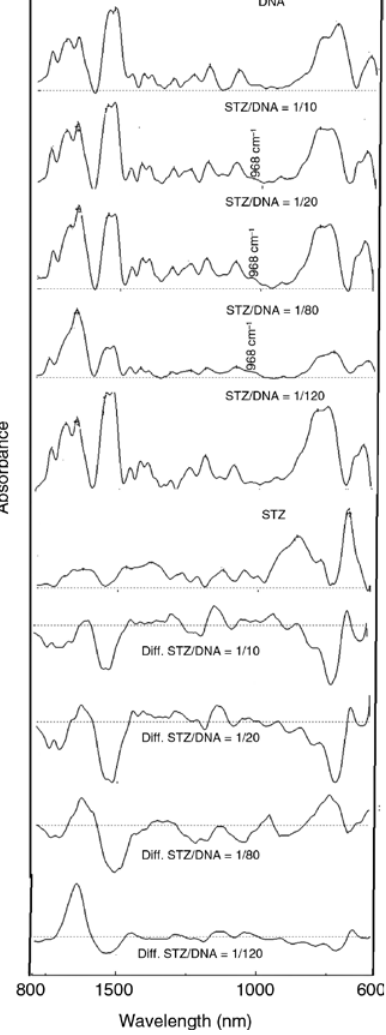
) vs. 1/[STZ], for the determination of Figure 2: Plot of 1/( A − A 0 binding constants of STZ-DNA adducts.